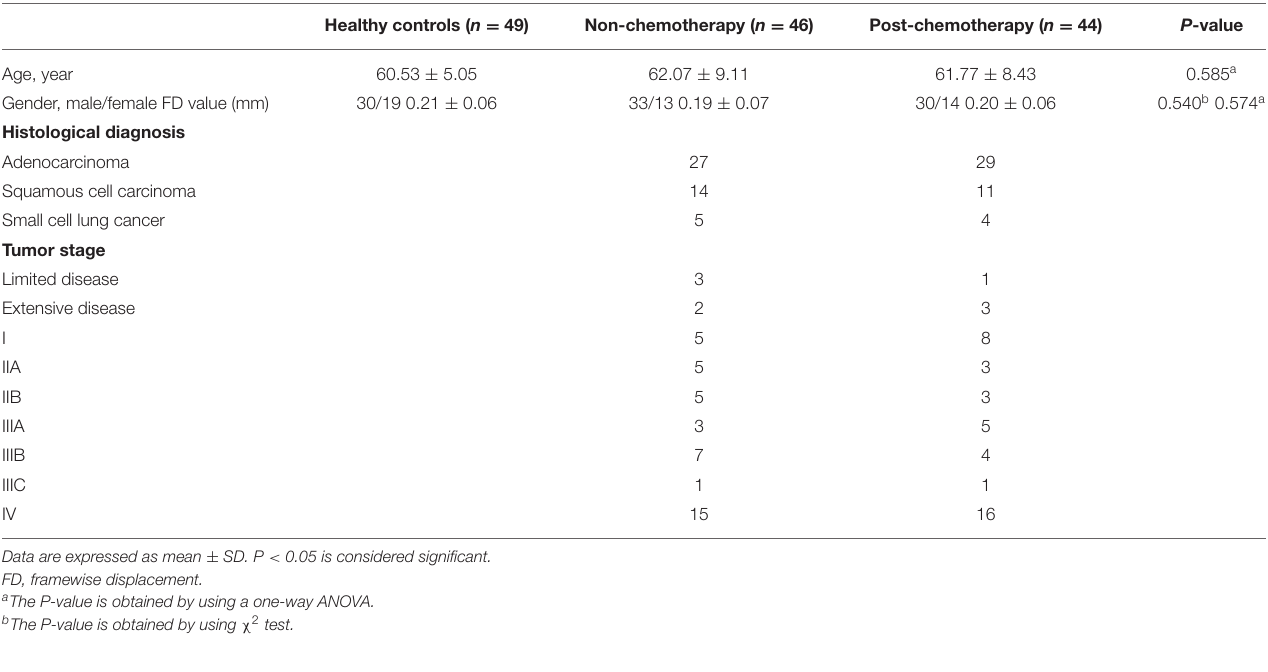
TABLE 1 | Demographic and clinical characteristics of all